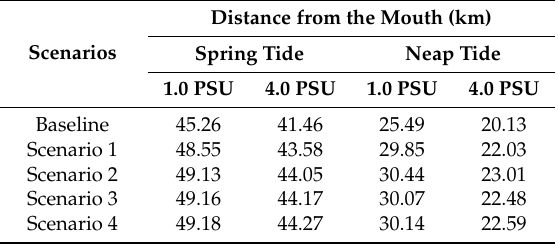
Table 7. Salinity intrusion length for thresholds of 1.0 PSU and 4.0 PSU for four scenarios, under spring tide and neap